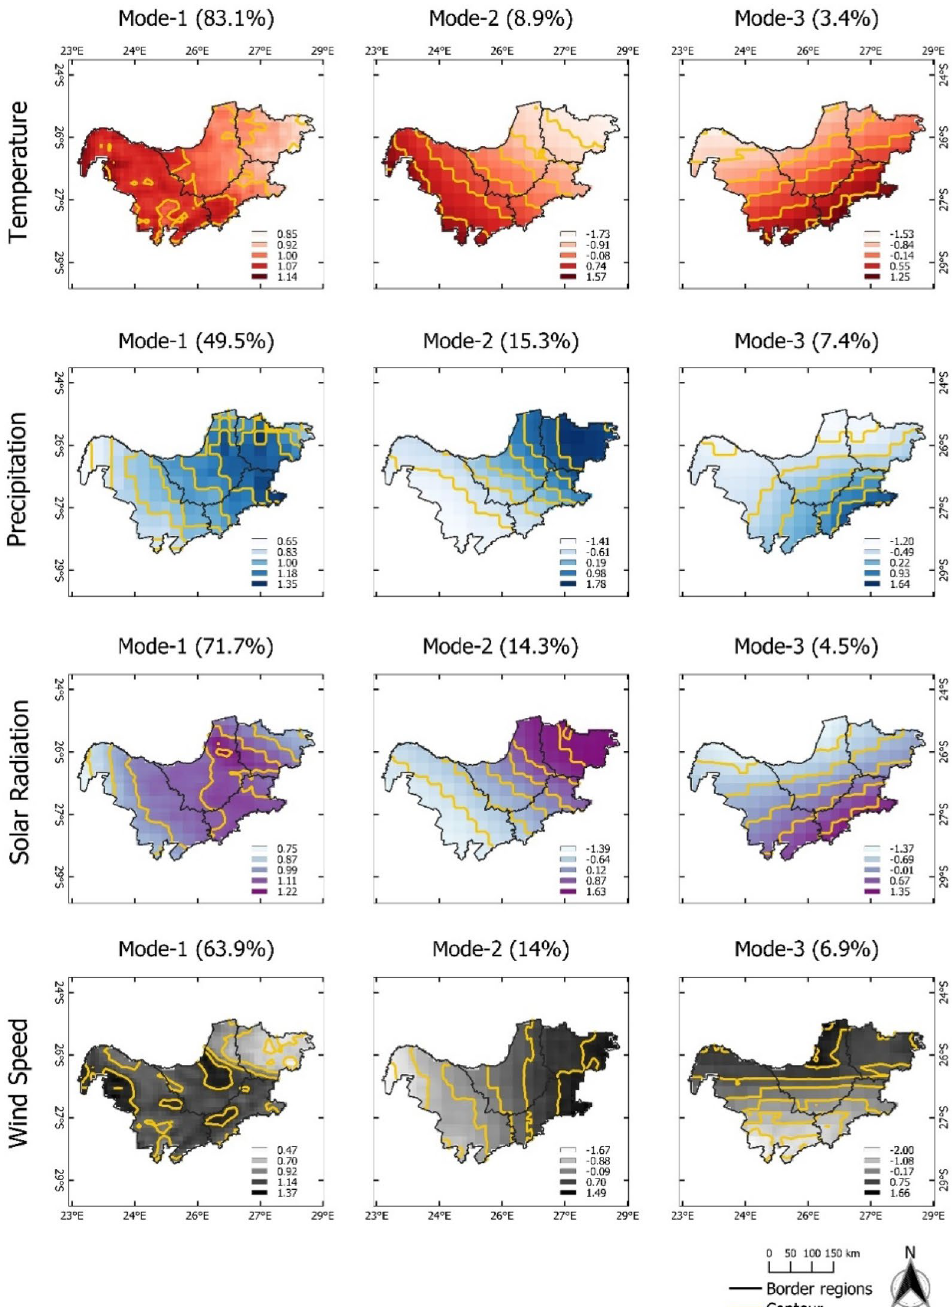
Figure 8. Map pattern of factor loadings for the first three modes (columns) derived from an EOF analysis for annual temperature, precipitation, solar radiation, and wind speed anomalies (rows) observed in the North West during the maize growing season of 1990/91–2020/21. Data for the maize growing season was used (cf. “Research data” section). Contour as for Fig.